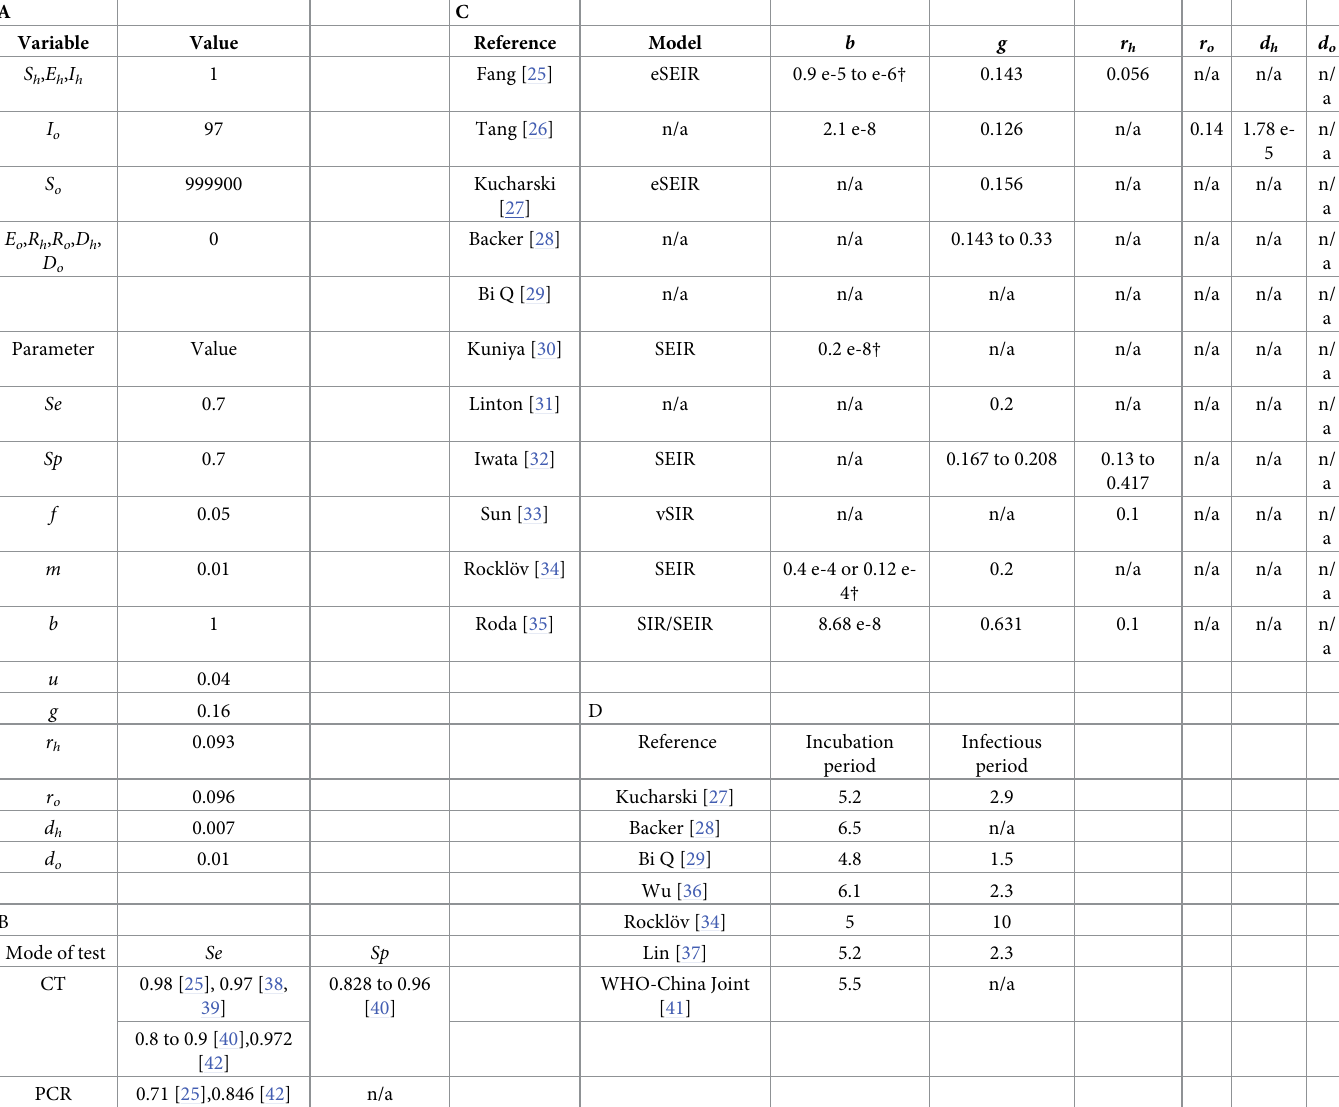
Table 1. Variables and parameters in reports during the early stages of the pandemic. (A) Initial values for variables and parameters, (B) Reported sensitivity and spec- ificity of the polymerase chain reaction (PCR) and CT for detecting COVID-19, Cells expressed as n/a indicate that we could not find the (C) reported transition parame- ters using models. Values with † are calculated from the original values for comparison. All values have a [one/day] dimension. We could not find values or models for the cells expressed as n/a. The values with † equal original values are divided by the total population, and (D) Reported incubation period and infectious periods. Each value has a [day]